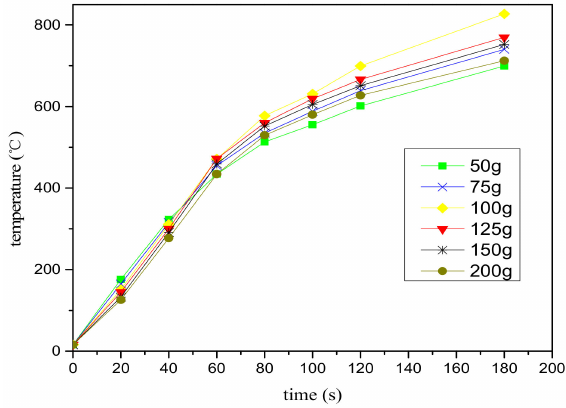
Figure 7. Heating curve of different masses of samples at a microwave power of 2.5